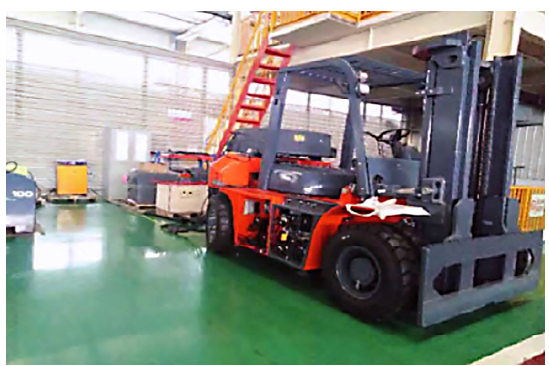
Figure 2. Experimental platform.